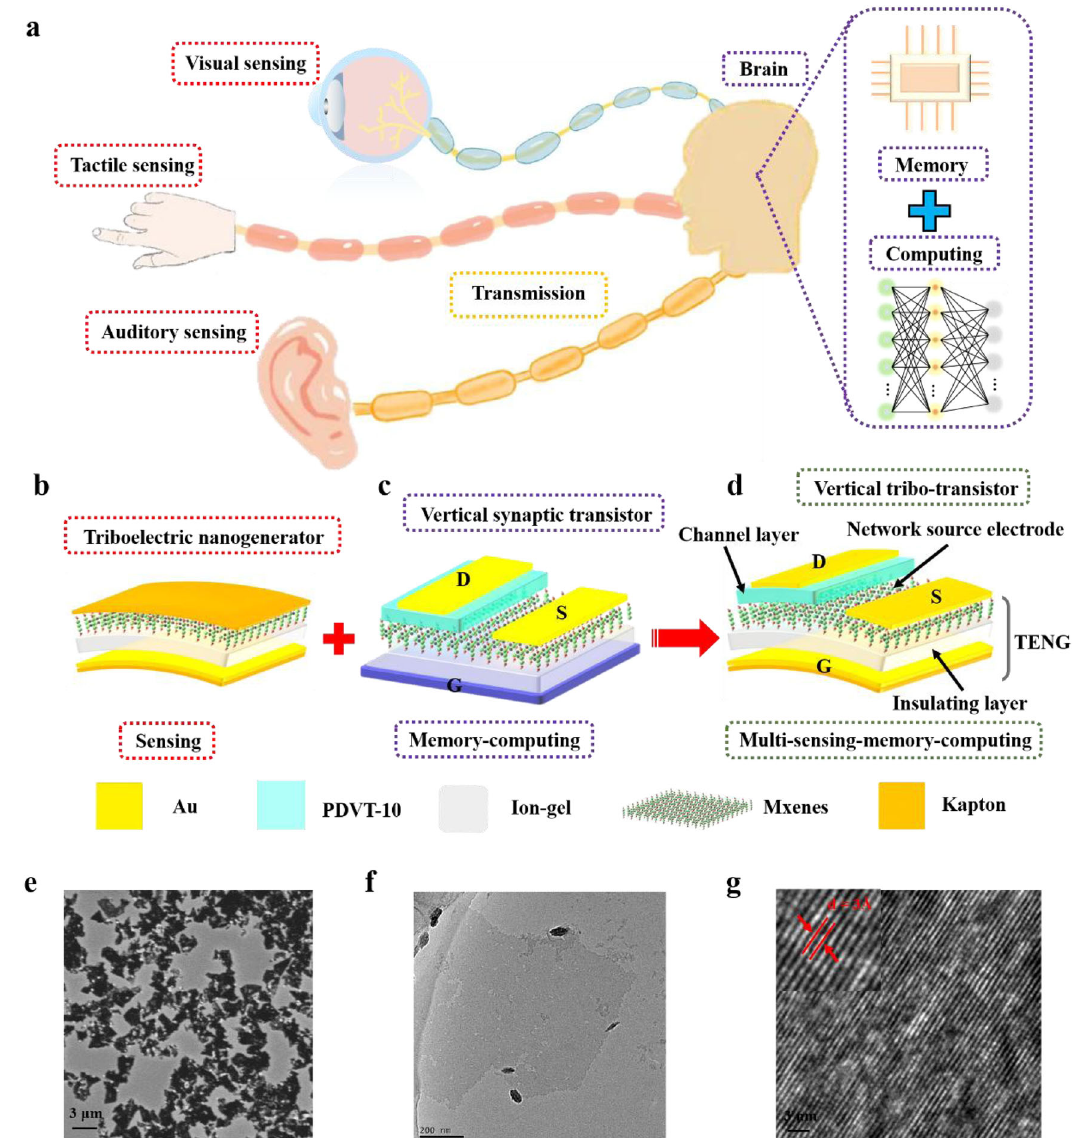
Fig. 1 | Schematic diagram of multi-sensing-memory-computing system, the device structure of VTT and its morphology characteristics. a The biological multi-sensing-memory-computing system. The sensory receptors collect sensory data and transmitted the data to humanbrain for further memoryand computing.